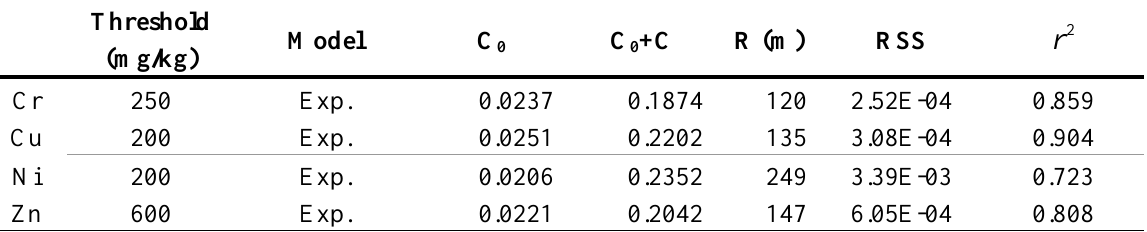
Table 2. Indicator variogram models for heavy metals.